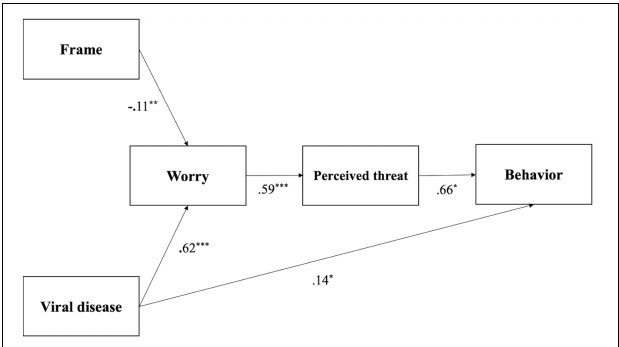
FIGURE 1 | Path model testing the indirect effect of Frame and Viral Disease on Behavior and the direct effect of Viral Disease on Behavior. Coefficients presented are standardized. ∗ p < 0.05, ∗∗ p < 0.01, ∗∗∗ p <